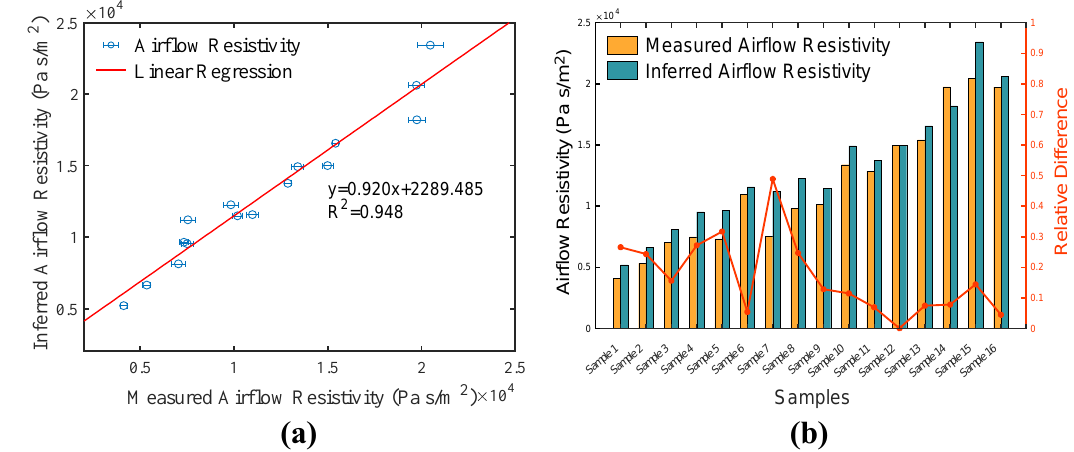
Figure 7. Comparison between measured and inferred airflow resistivity: ( a ) correlation between the measured and inferred values, and ( b ) their relative difference.